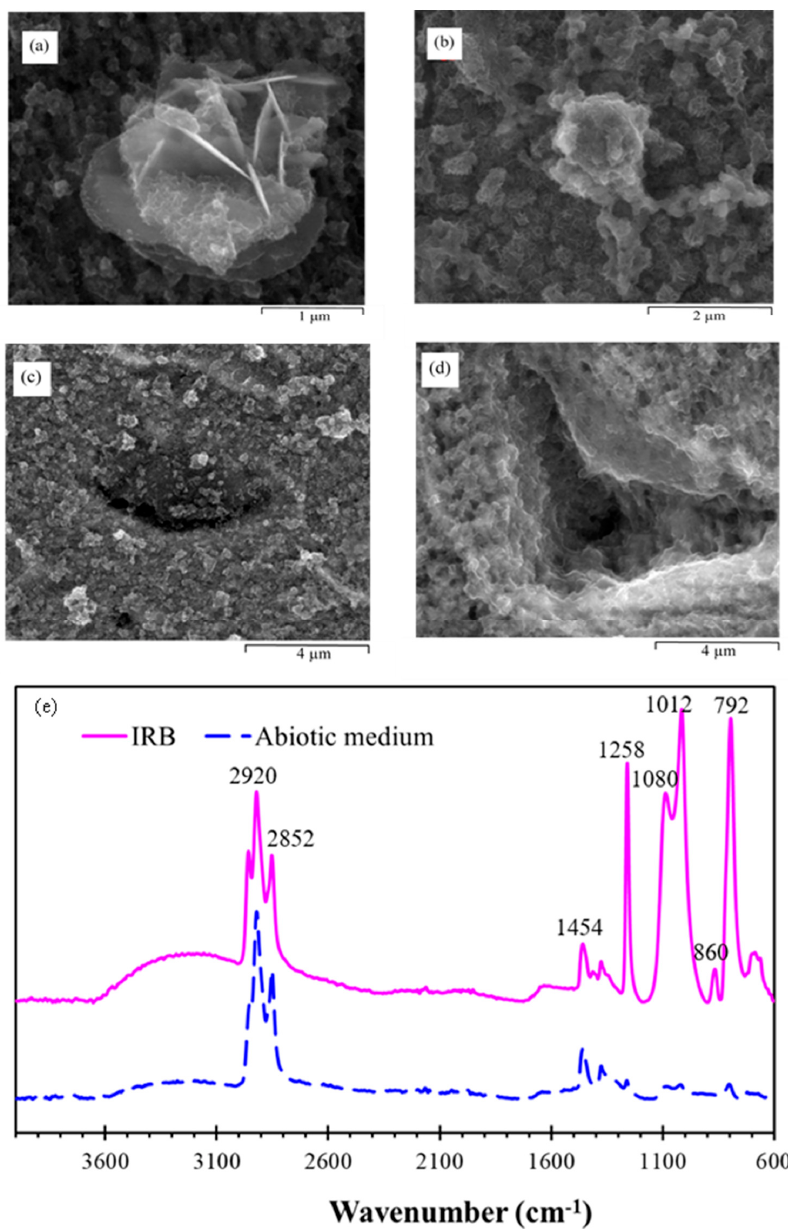
Figure 3. ESEM images of hydrated biofilm formed on carbon steel by a pure IRB culture following 72 h exposure to Postgate C medium, ( a , b ) reduced Fe(II) oxide species, ( c ) sites of pitting attack under loose cap of corrosion product and ( d ) pit initiated at a MnS inclusion site. ( e ) IR spectra of IRB biofilm formed on carbon steel upon to exposure to pure IRB culture in Postgate C medium and abiotic Postgate C for a period of 72 h.